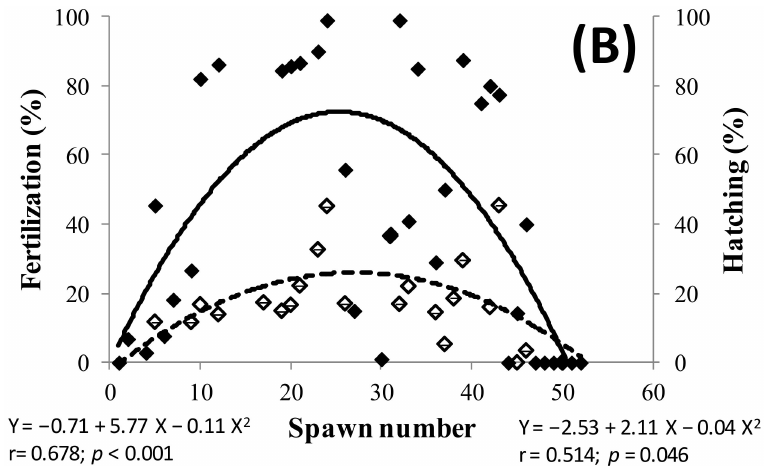
Figure 7. Fertilization (solid rhombus) and one-day embryo survival (open rhombus) in relation to daily egg released ( A ), and fertilization (solid rhombus) and hatching success (open rhombus) in relation to number of spawn ( B ).